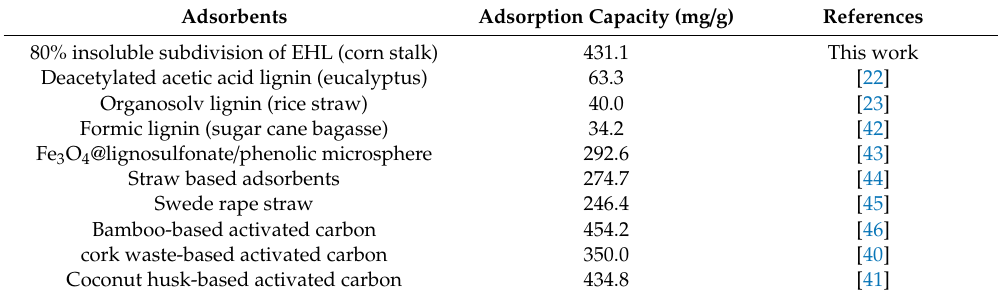
Table 3. The maximum monolayer adsorption ( Q m ) of methylene blue onto various adsorbents. Adsorbents